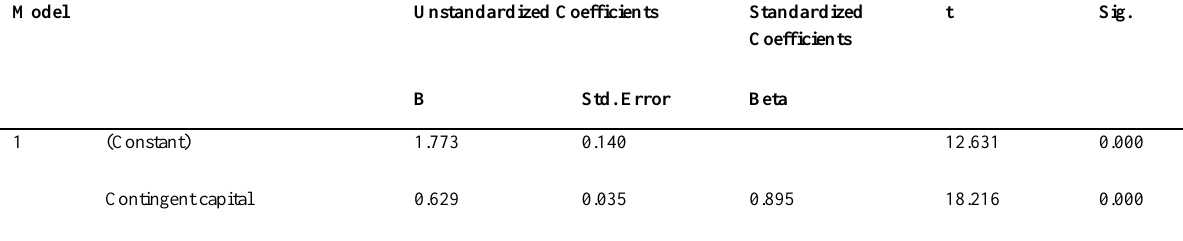
Table 5: Coefficients for the Regression of contingent capital and Performance of Hydroelectric Energy projects